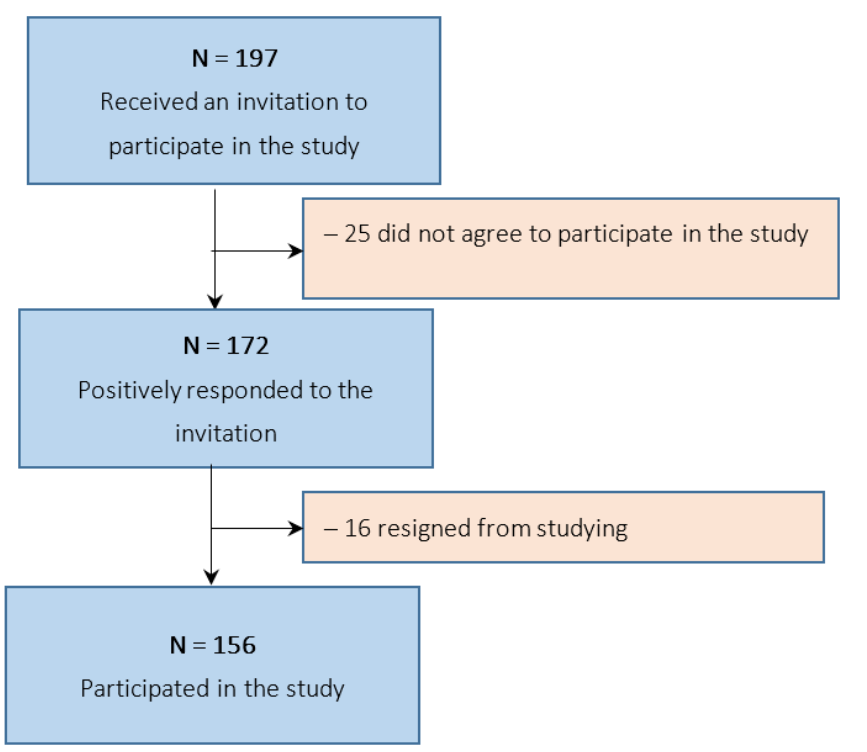
Figure 1. Flowchart of participant enrolment.